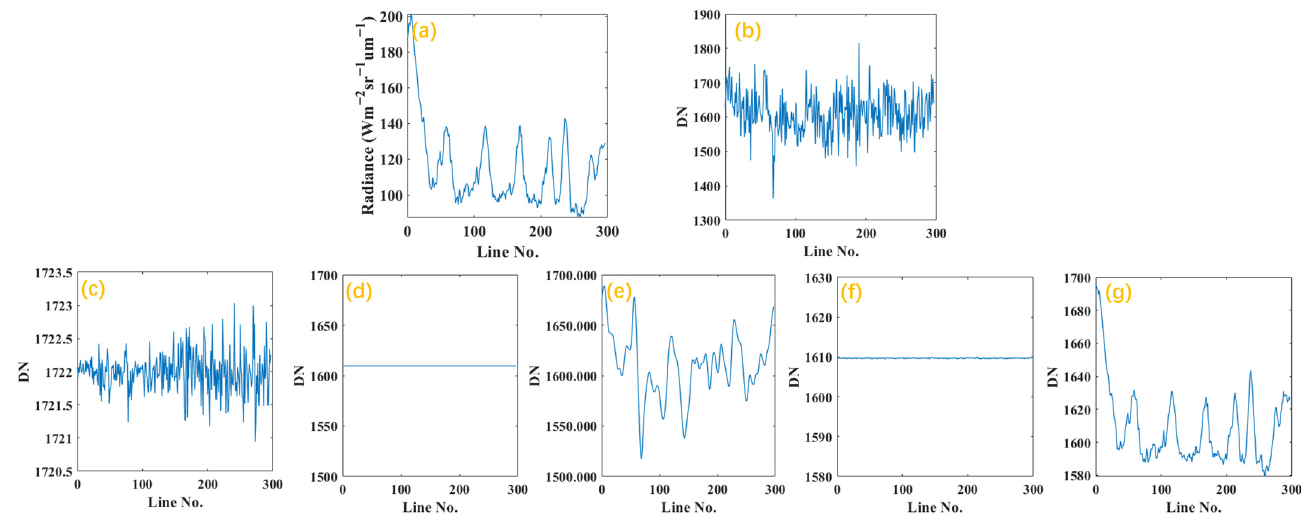
Figure 9. Longitudinal averages of the laboratory MMS N-WIR (central wavelength of 1368.2 nm) data in linear stretched images. ( a ) Correctly corrected longitudinal radiance averages of N-WIR and ( b ) original N-WIR longitudinal DN averages. Longitudinal DN averages based on the ( c ) HM, ( d ) MM, ( e ) BW, ( f ) TV, and ( g ) proposed method.